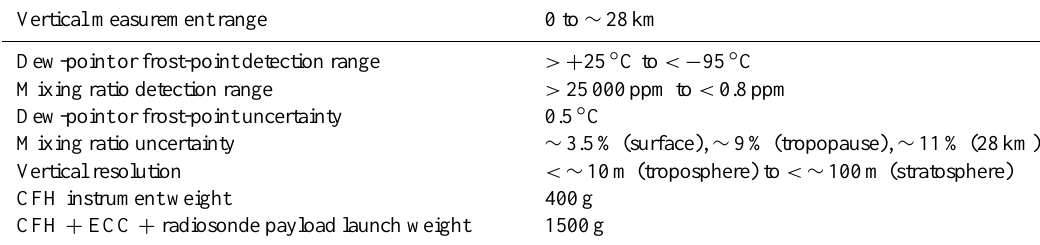
Table A1. CFH specifications. Vertical measurement